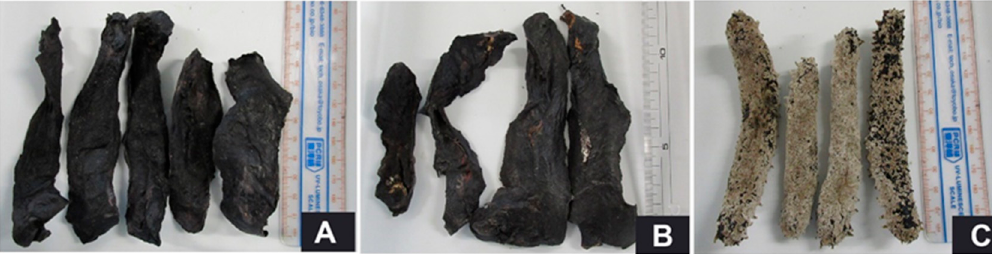
Figure 1. Sea cucumber species after dissection and drying. ( A ) Holothuria atra ; ( B ) Holothuria leucospilota ; ( C ) Parastichopus nigripunctatus.